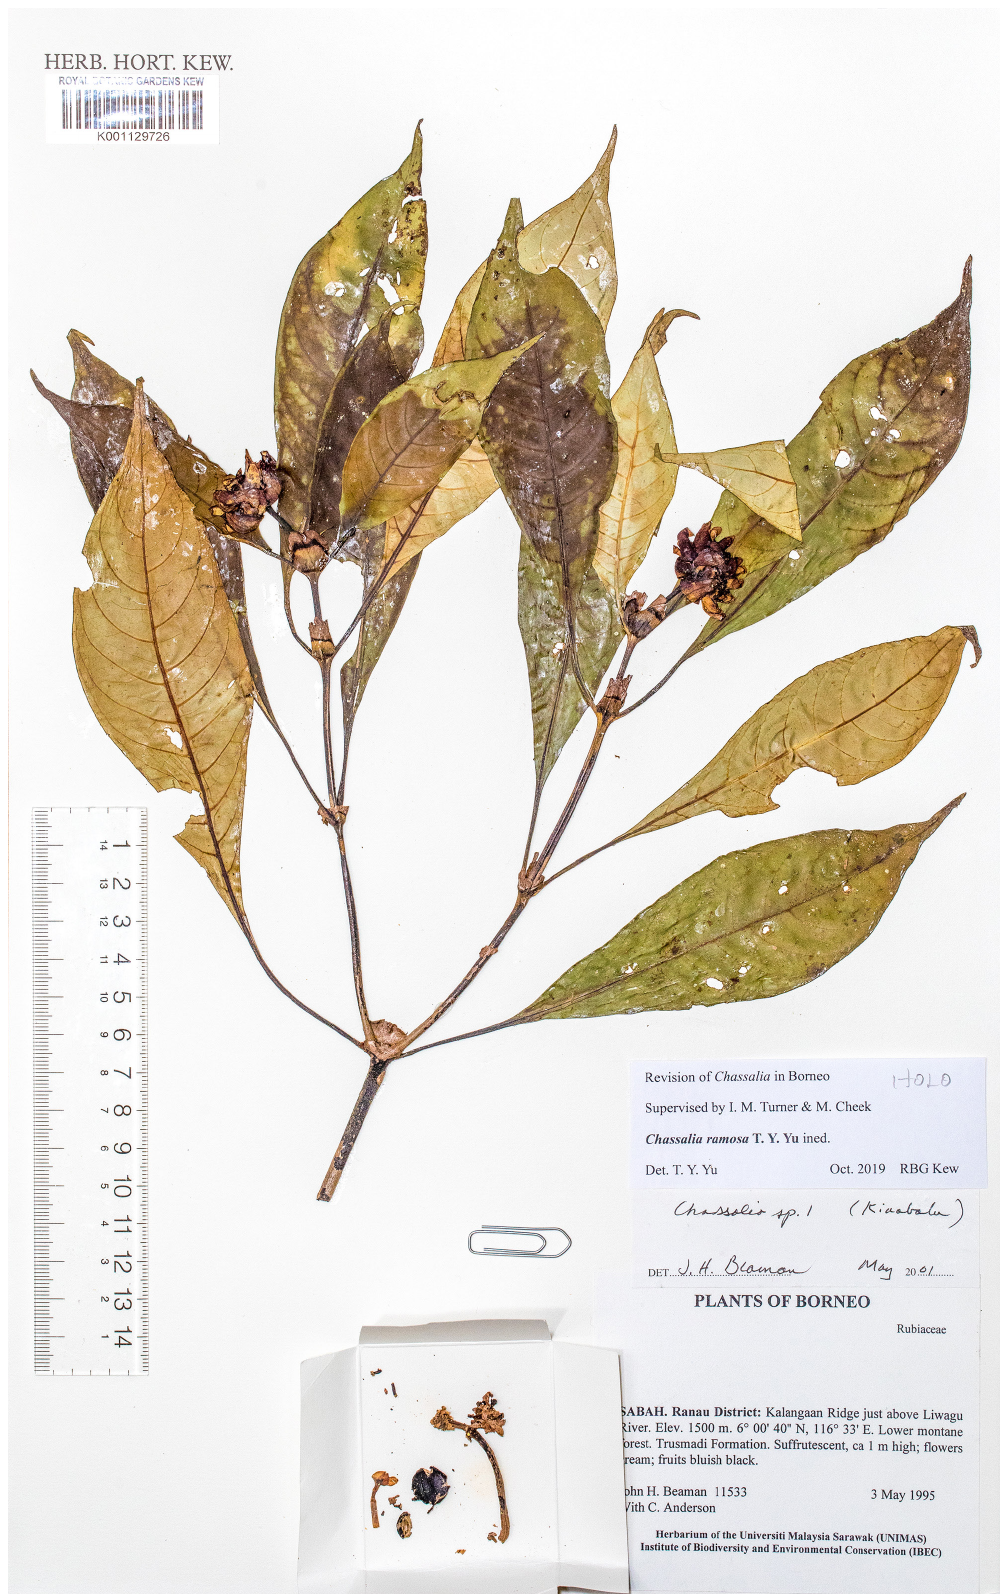
Fig. 31. Holotype of Chassalia ramosa T.Y.Yu sp. nov. ( John H. Beaman 11533